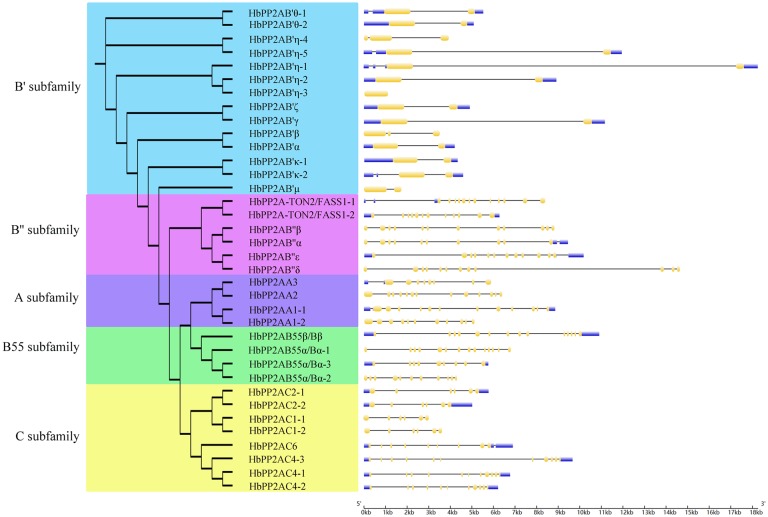
The exon/intron organization of the HbPP2As family.Thin black lines indicated introns. Thick yellow and thick blue boxes indicated coding sequence and untranslated region, respectively.